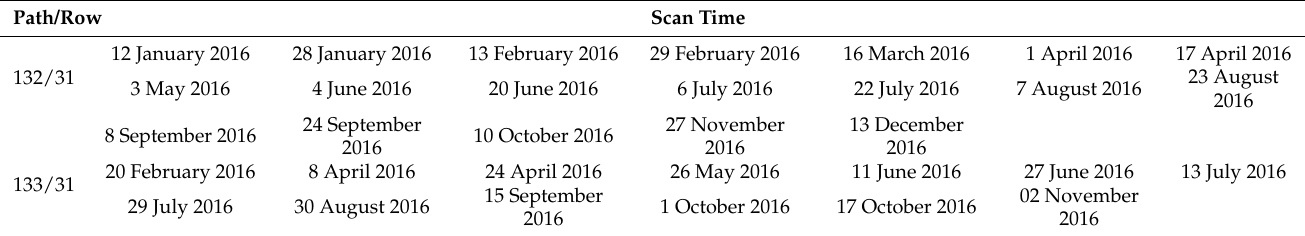
Table 1. OLI images obtained from orbits 132/031 and 133/031. Scan